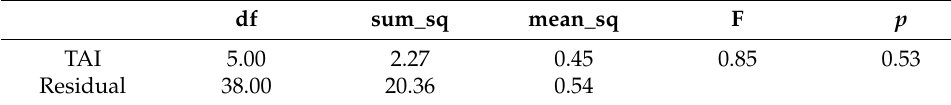
Table A3. ANOVA results for the time after irrigation effect on the LAI.